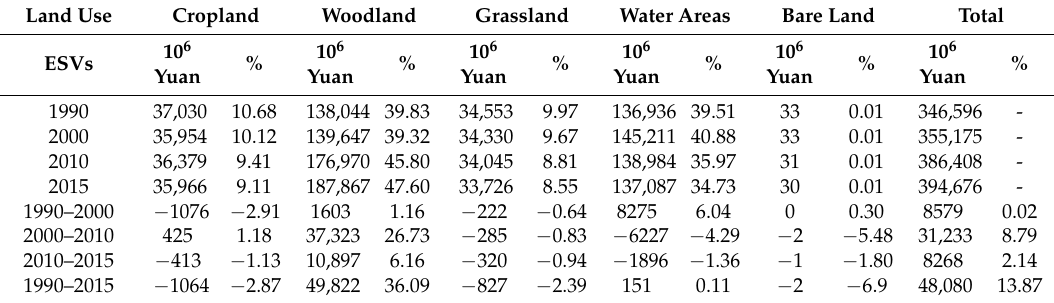
Table A3. Changes in ecosystem service values (ESVs) for each land use type from 1990 to 2015 in the Jing-Jin-Ji